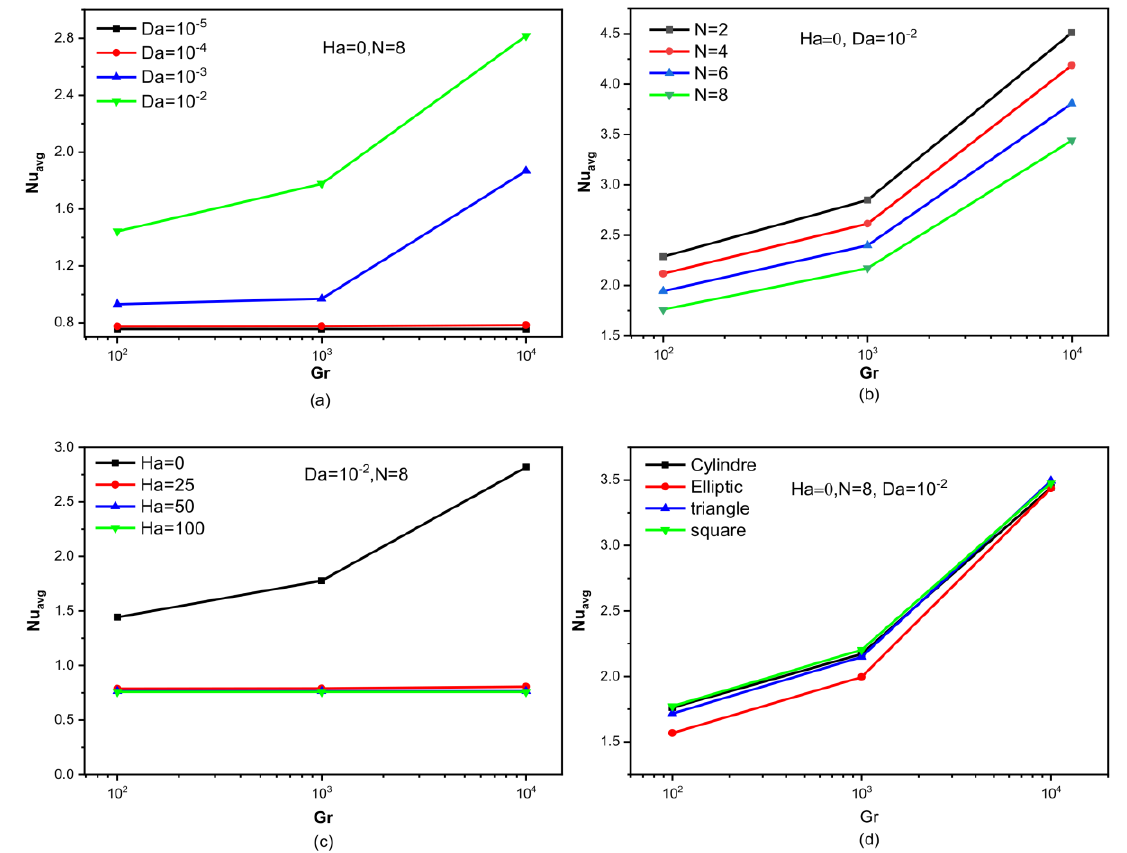
Figure 8. Average Nusselt number versus Grashof numbers for different ( a ) Darcy numbers, ( b ) undulation numbers, ( c ) Hartmann numbers, and ( d ) obstacles shapes for Da = 10 − 2 , Ha = 0, and N =